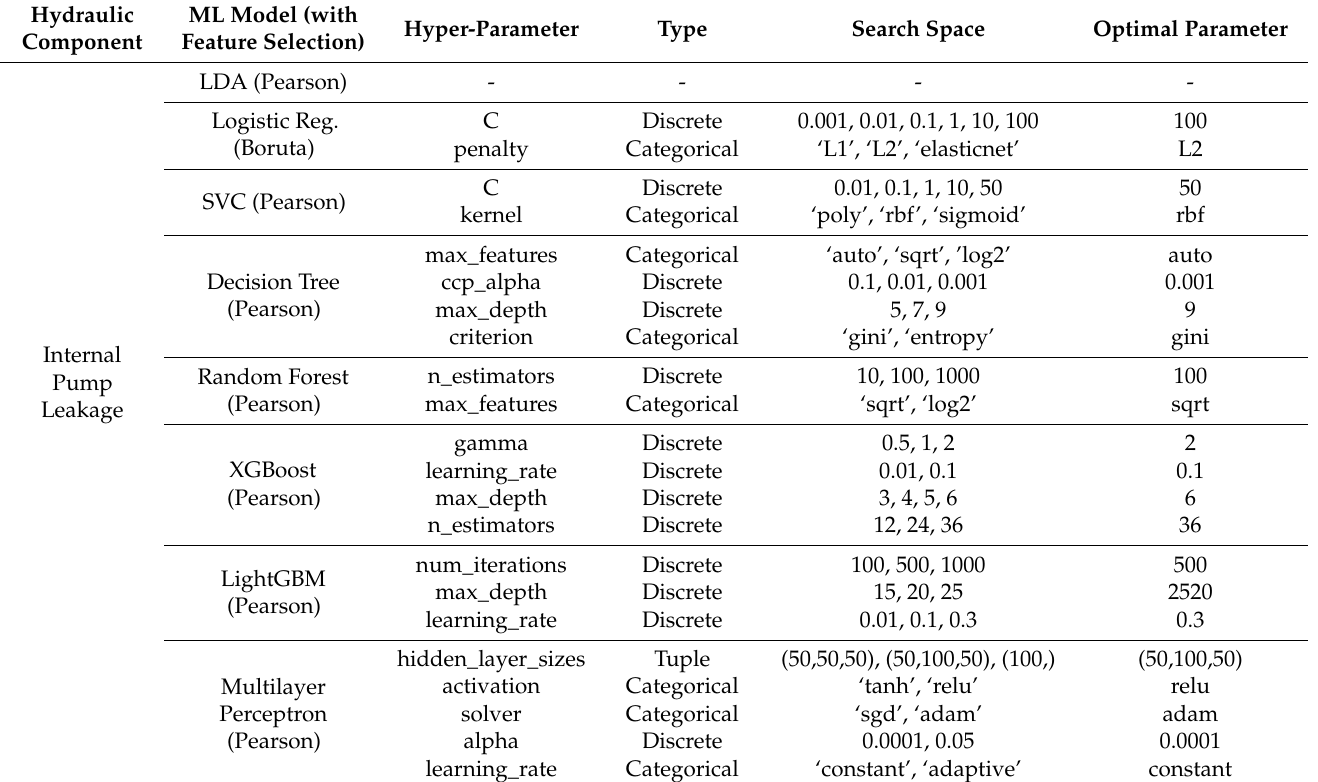
Table 9. Hyper-parameter configuration space and optimal parameter under internal pump